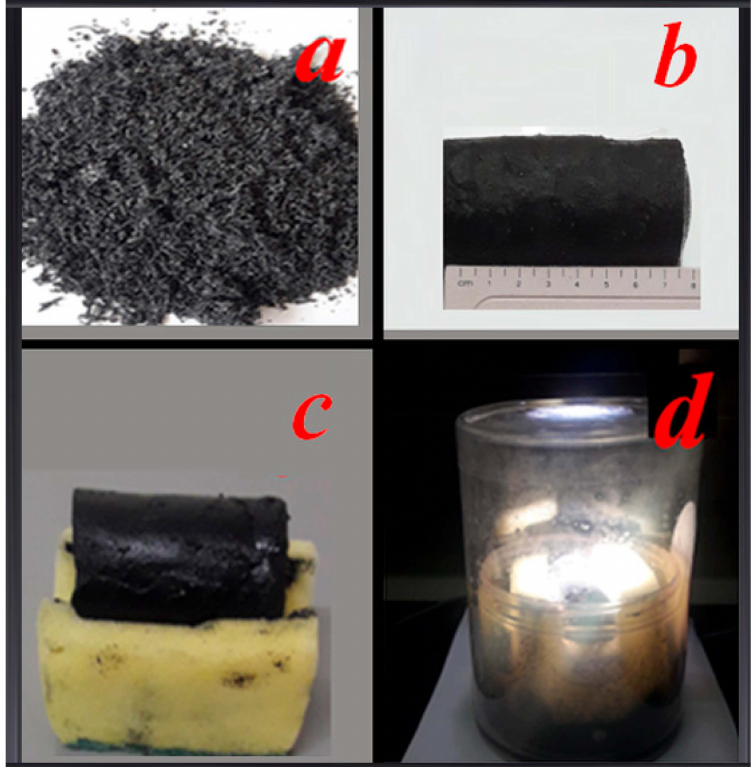
Figure 1. Digital images of pristine graphite ( a ); 3D black TiO 2 /Ag/N@rGO ( b ); the cellulose sponge support and thermal insulator ( c ); and the interfacial desalination setup with the solar absorber enclosed in a transparent plastic cover to shield radiative and convective heat losses, illuminated with 1-sun solar irradiation ( d